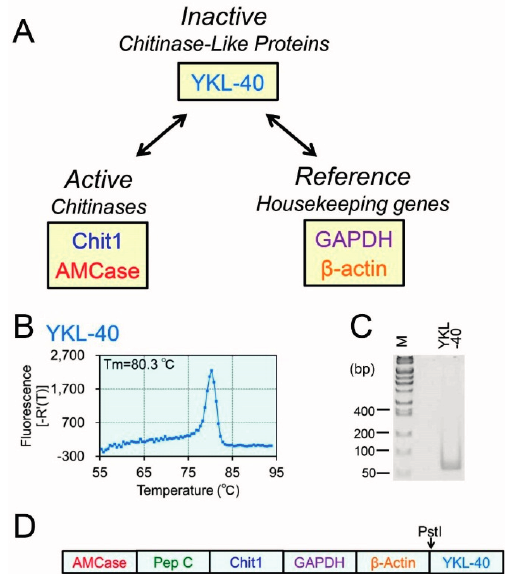
Figure 1. Strategy for comparing the gene expression levels of YKL-40, chitinases and housekeeping genes and construction of the Refs/YKL-40 standard DNA. ( A ) The expression of YKL-40 was quantified and subsequently, the levels of YKL-40, active chitinases (Chit1 and AMCase) and housekeeping genes (GAPDH and β -actin) were compared; ( B , C ) Evaluation of primer suitability for qPCR. The primers were evaluated based on whether they displayed single melting temperature ( B ) and a single PCR product on a 10% polyacrylamide gel ( C ); The y -axis was expressed as first derivative of the fluorescence as a function of temperature ( B ). To verify the specificity, the dissociation curves of YKL-40 PCR products were generated using a human tissue cDNA mixture. The PCR products were analyzed polyacrylamide gel electrophoresis, followed by ethidium bromide staining; and ( D ) schematic representation of the human Refs/YKL-40 standard DNA used for real-time PCR